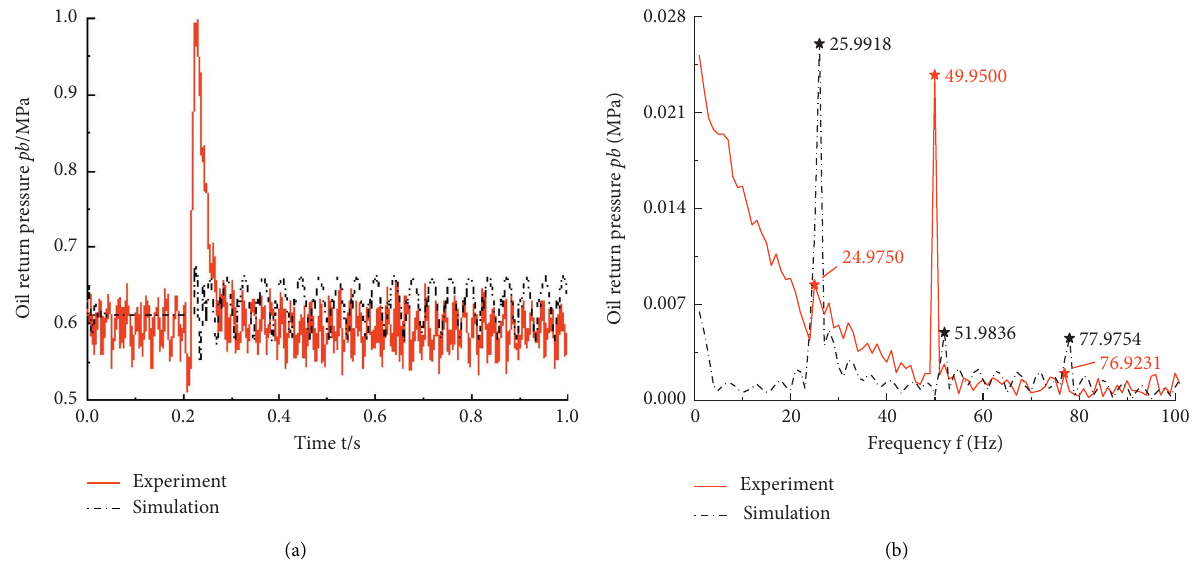
Figure 4: Simulation results of oil return pressure p